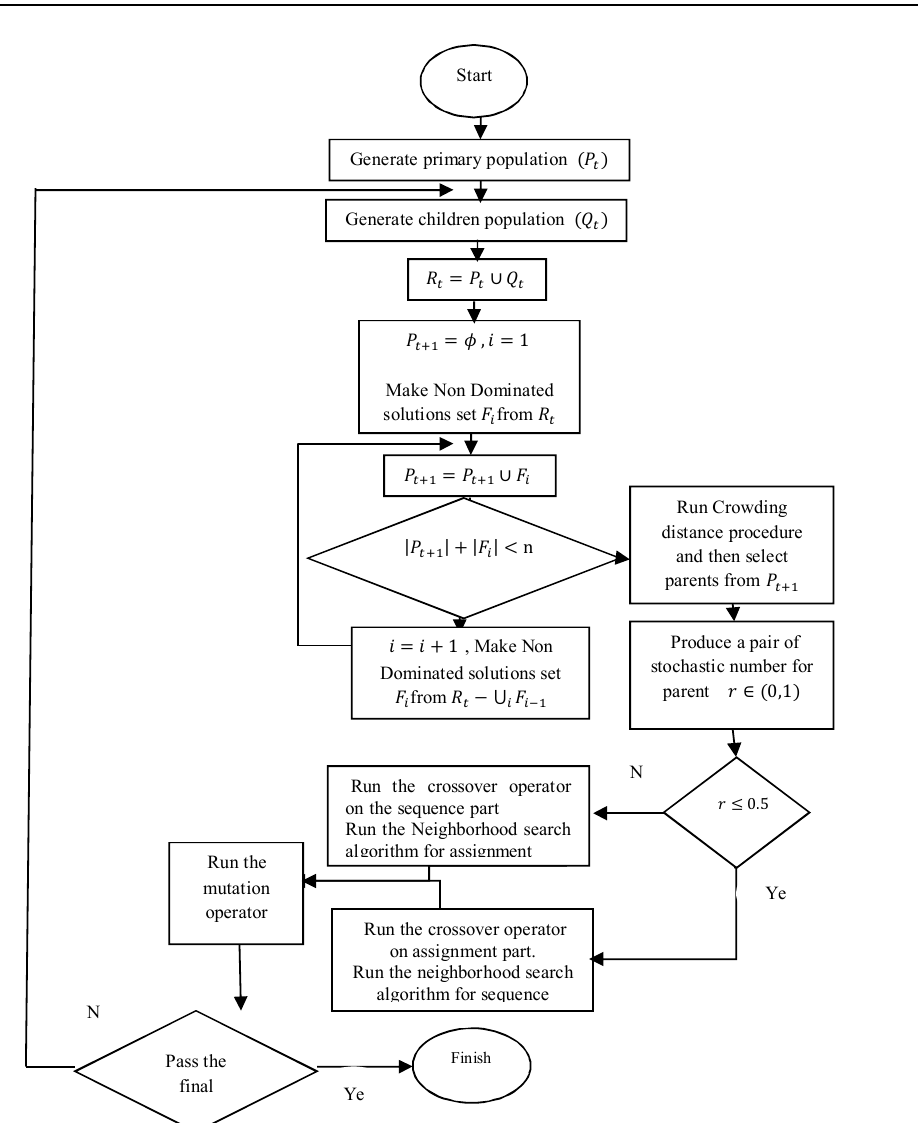
Fig. 1. Structure of the proposed